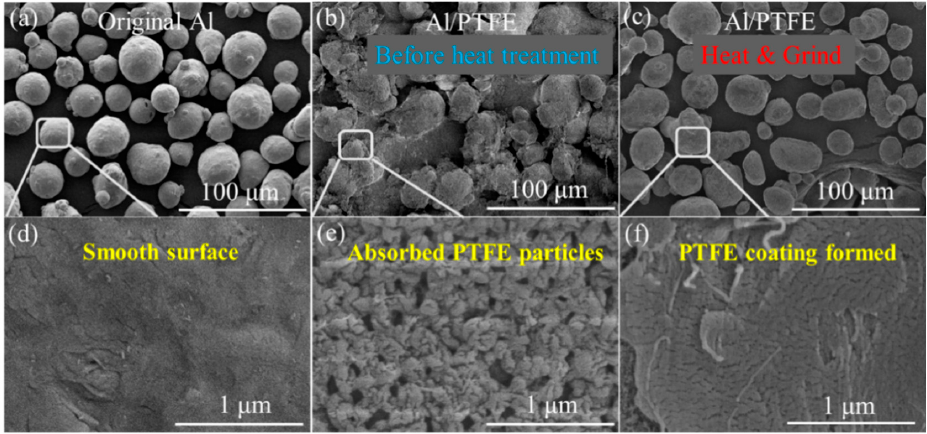
Figure 3. SEM images of Al / PTFE composites: ( a , d ) original Al powders; ( b , e ) Al / PTFE before heat treatment; ( c , f ) Al / PTFE after heat treatment. The maximum heating temperature (T h ) is 335 ◦ C, the total heating time (t h ) is 4